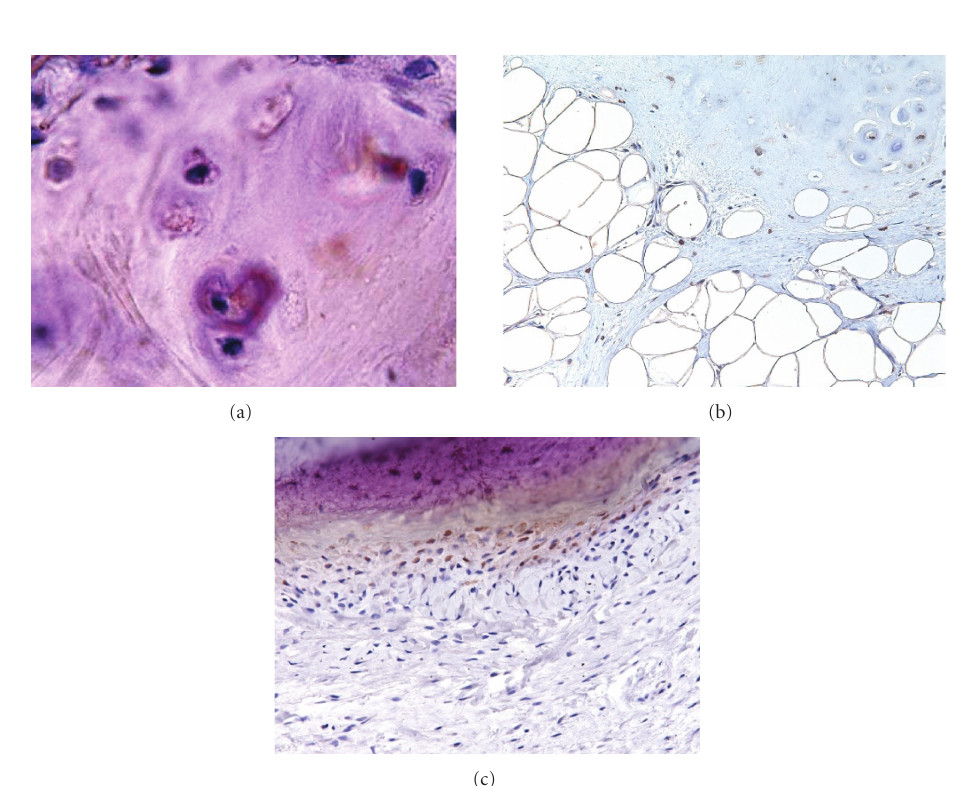
Figure 3: (a) Some chondrocytes reveal positive immunoreactivity for RUNX-2 (RUNX-2, original magnification × 600). (b) Spindle cells around cartilage tissue and some chondroblastic like cells reveal positive immunoreactivity for Sox-9 (Sox-9, original magnification × 200). (c) Osteoblastic cells reveal positive immunoreactivity for RUNX-2 (RUNX-2, original magnification × 200).